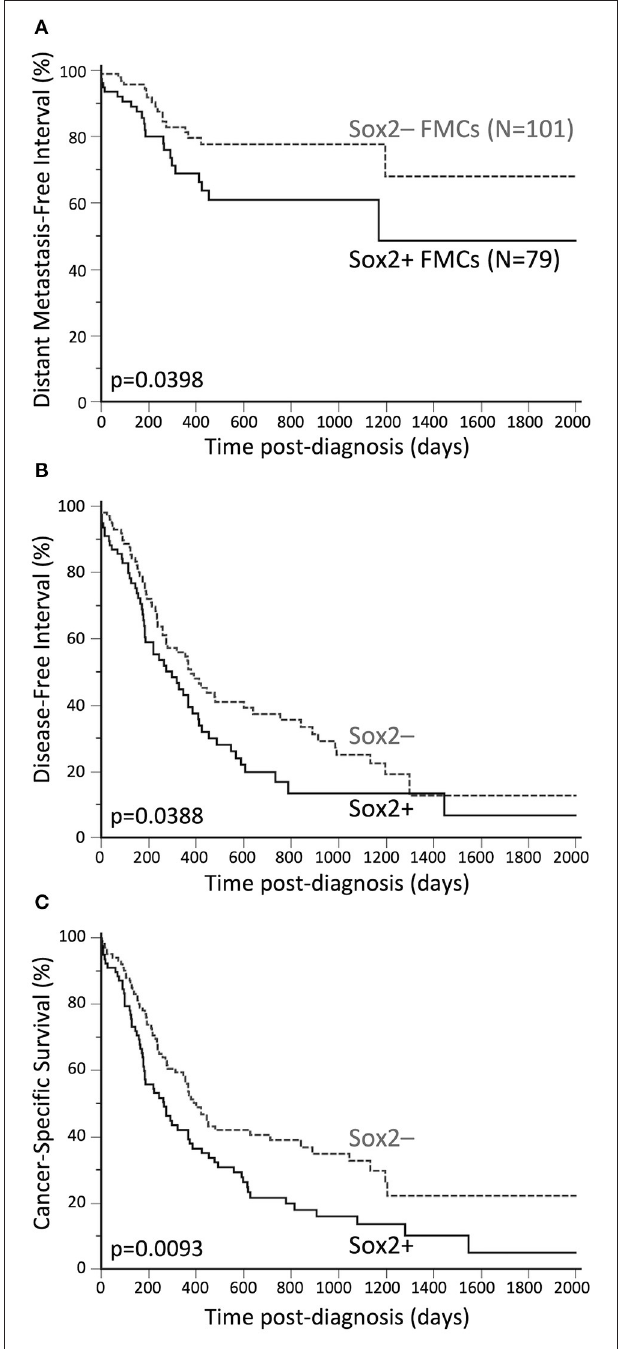
FIGURE 2 | Unfavorable prognostic significance of Sox2 in FMCs. (A) Distant Metastasis-Free Interval. The probabilities of distant metastasis at 2 years post-diagnosis were 22% in the Sox2– group, and 39% in the Sox2 + group. (B) Disease-free interval. The median DFI was 12.4 months in the Sox2– group, and 9.7 months in the Sox2 + group. The probabilities of cancer progression at 2 years post diagnosis were 63% and 80% in the Sox2– and Sox2 + groups, respectively. (C) Cancer-specific survival. The median SS times were 13.1 and 8.7 months in the Sox2– and Sox2 + groups, respectively. At 2 years post-diagnosis, 61% of the cats in the Sox2– group, and 78% of the cats in the Sox2 + group had died from cancer. Kaplan-Meier curves.